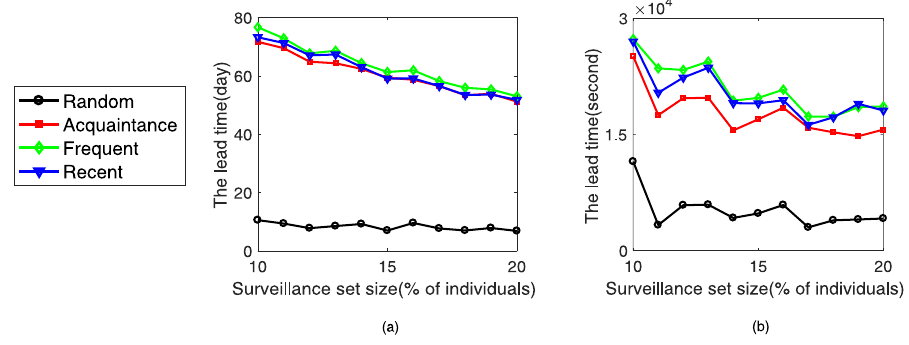
Figure 6. The size of surveillance set impacts performance on two randomized temporal networks. The lead time as function of the fraction of sentinels for the ( a ) randomized Prostitution network and ( b ) randomized Email network. The colors for the surveillance strategies are the same as in Fig. 4.